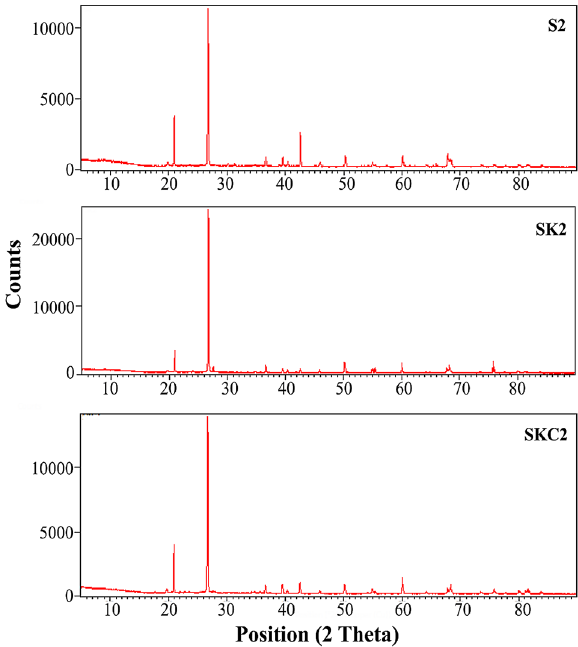
Fig. 4 XRD patterns for the samples S2, SK2, and SKC2. A negative (left) shift in the characteristic peaks is clearly visible for the samples SK2 and SKC2, as compared to S2